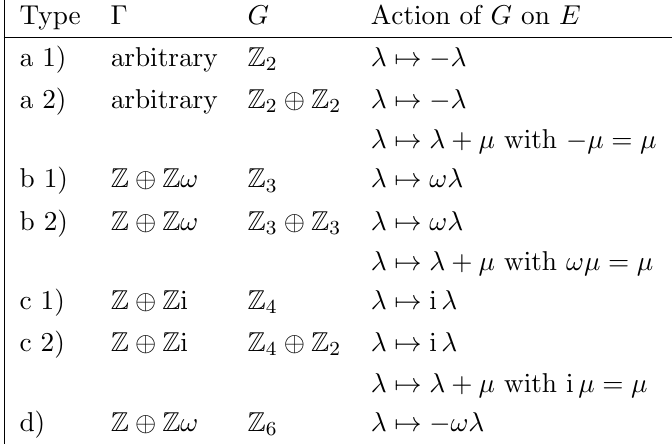
Table 1 . The classi(cid:12)cation of bi-elliptic surfaces. ! is a cubic unit root. This table is taken from